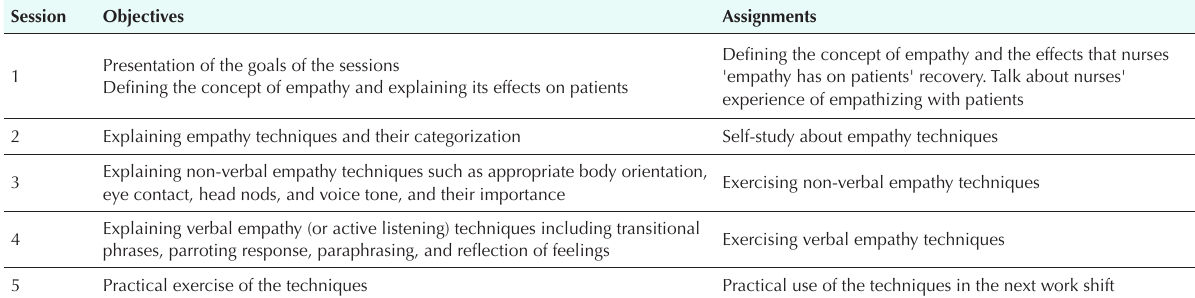
Table 1. The content of the empathy education sessions Session Objectives